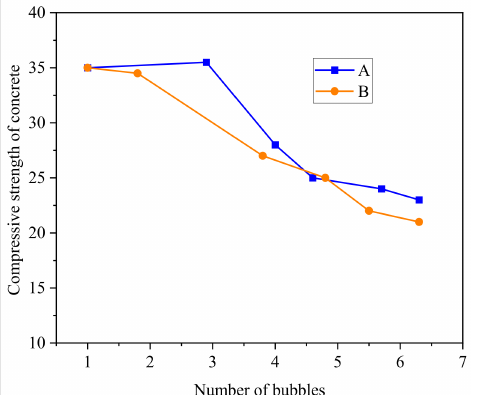
Figure 25. The effect of bubble content on compressive strength. Concrete test blocks with different mix proportions A and B.